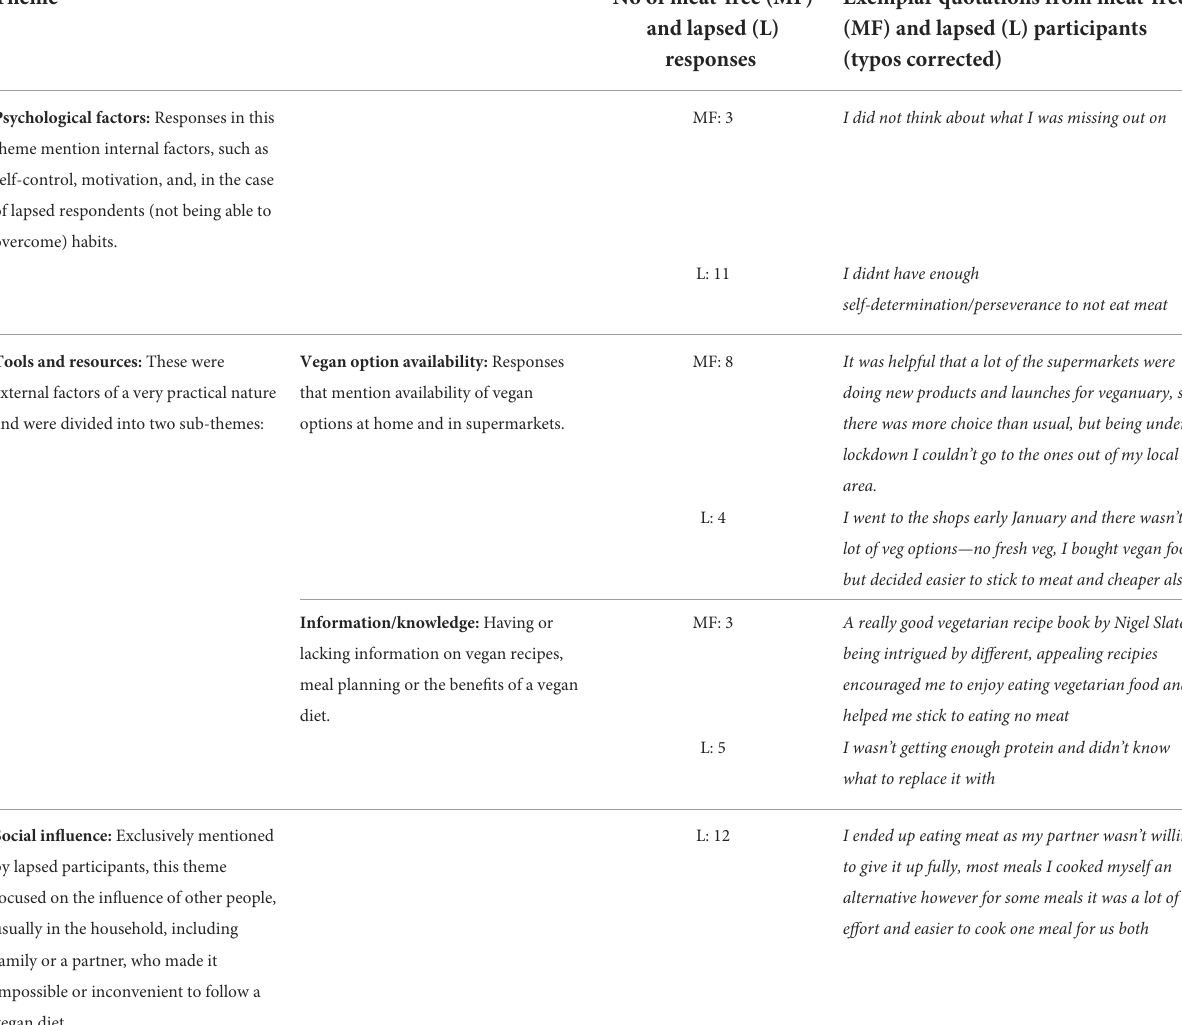
TABLE 5 Results from thematic analysis of challenging and helpful factors in maintaining a meat-free diet during Veganuary. Theme No of meat-free (MF)